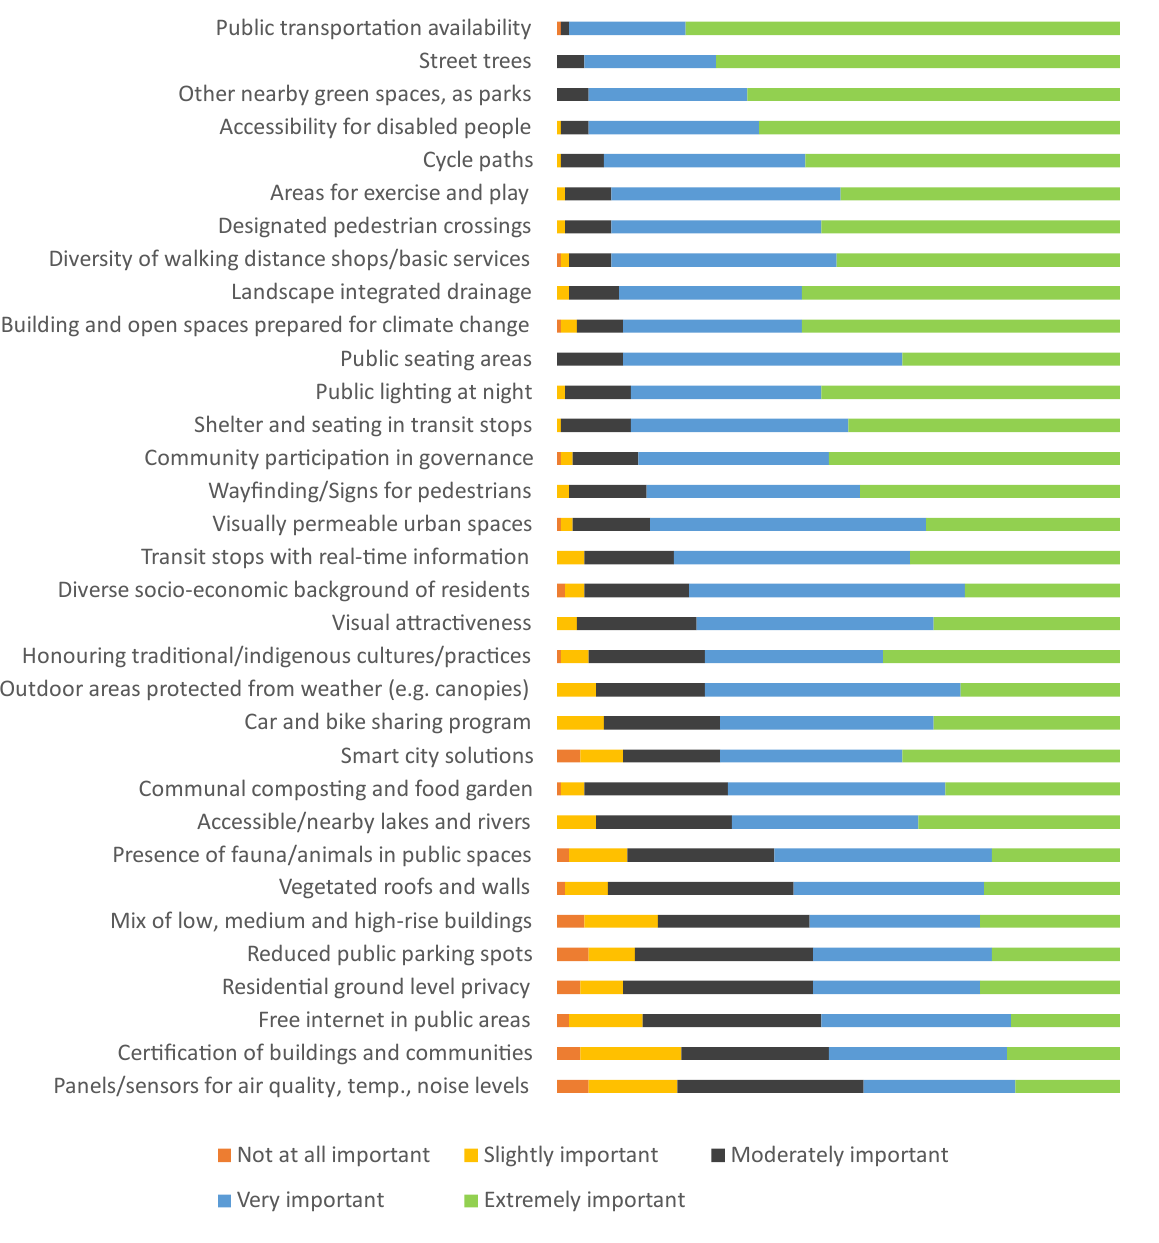
Figure 13. Perception of importance of strategies for a regenerative and circular neighbourhood.